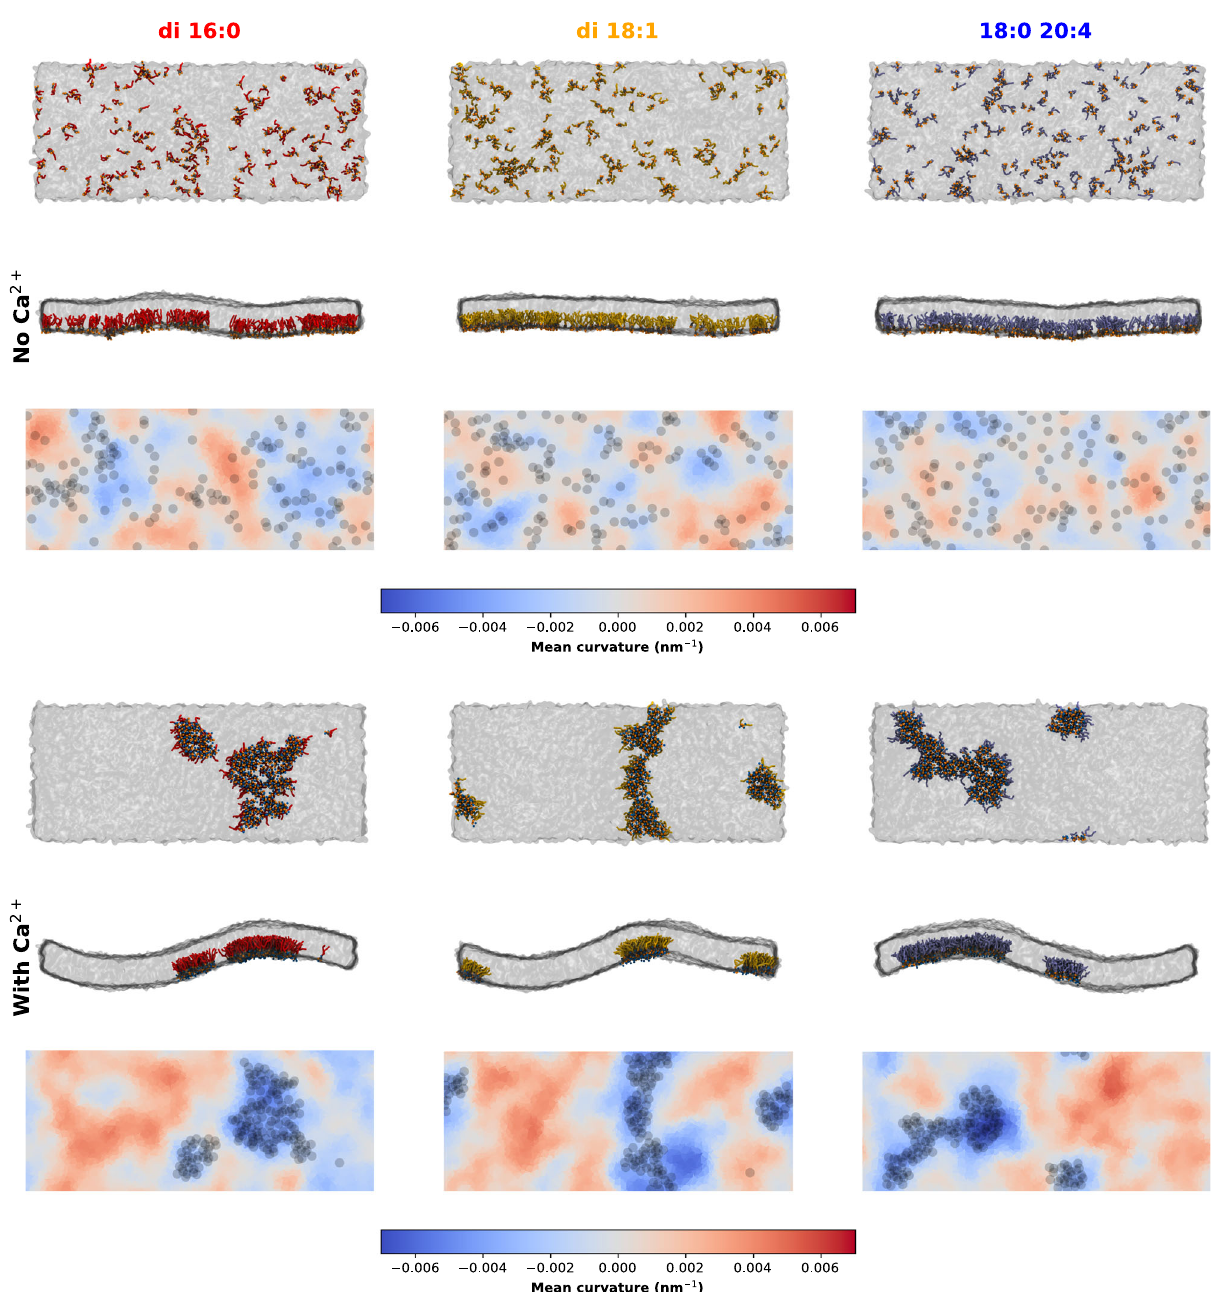
Fig. 6 Calcium-induced PI(4,5)P 2 clustering induces negative membrane curvature, as seen by CG MD simulations. Curvature analysis of snapshots from asymmetric membrane simulations containing 10 mol% PI(4,5)P 2 in the inner lea fl et. Snapshots are shown for the three acyl-chain compositions studied, both in the presence and absence of calcium. For each system, a top and side view are presented, as well as a top view colored by local mean curvature value. PI(4,5)P 2 phosphodiester (PO4) beads are represented by the black circles. In the molecular representations, PI(4,5)P 2 headgroups are depicted in gray, with the phosphates discriminated in orange. PI(4,5)P 2 acyl chains are colored according to the corresponding color code. Ca 2 + ions are represented in blue. The bulk POPC lipids are represented by the translucent gray